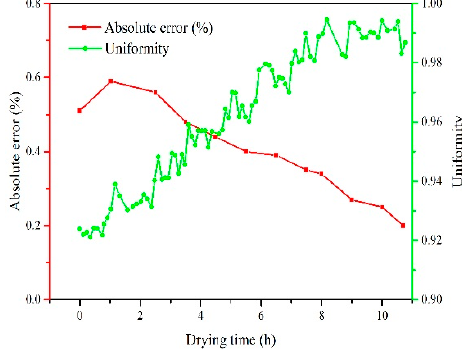
Figure 17. Absolute error and uniformity of moisture content in the process of online measurement.